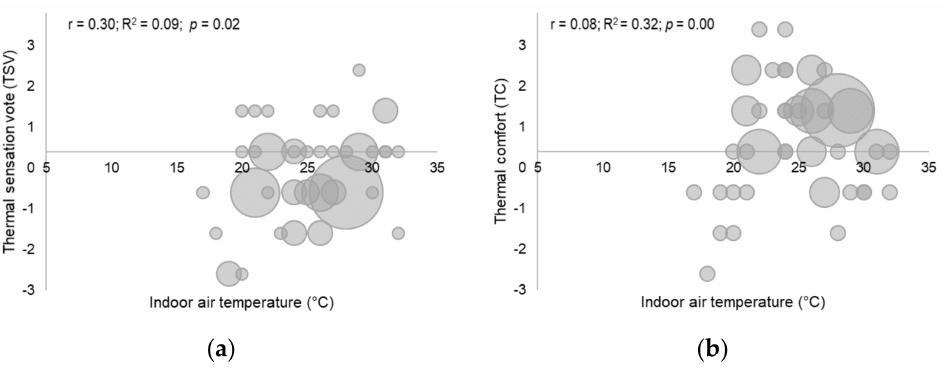
Figure 7. Correlation between ( a ) indoor air temperature and thermal sensation, and ( b ) indoor air temperature and thermal comfort.